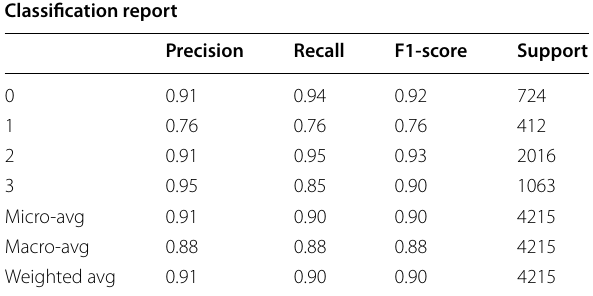
Table 6 Evaluation indicators Classification